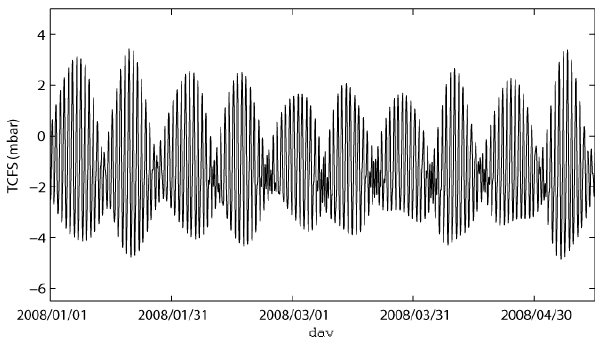
Figure 3. Temporal variations in TCFS caused on the focal fault plane of the Wenchuan earthquake at a depth of 19km. The date is given in the format